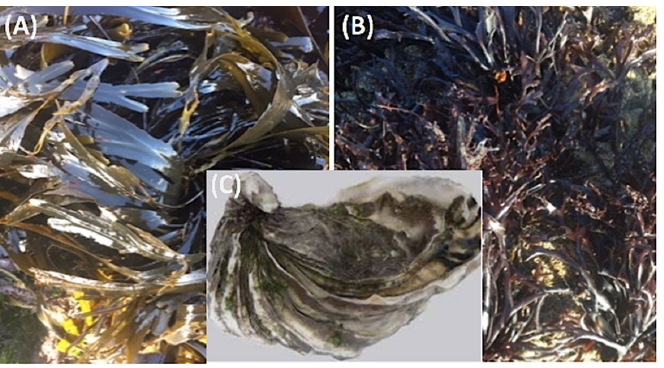
Figure 1. Seaweed species ( A ) Bladder wrack Fucus vesiculosus , ( B ) false Irish moss Mastocarpus stellatus, and ( C ) Pacific oyster Crassostrea gigas .